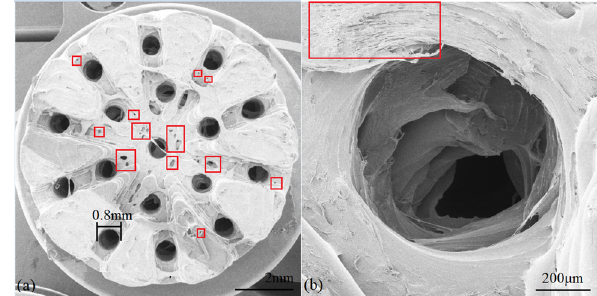
Figure 4: The surface morphology of ( a ) a scaffold with uniform pores and ( b ) the enlarger of the one of the